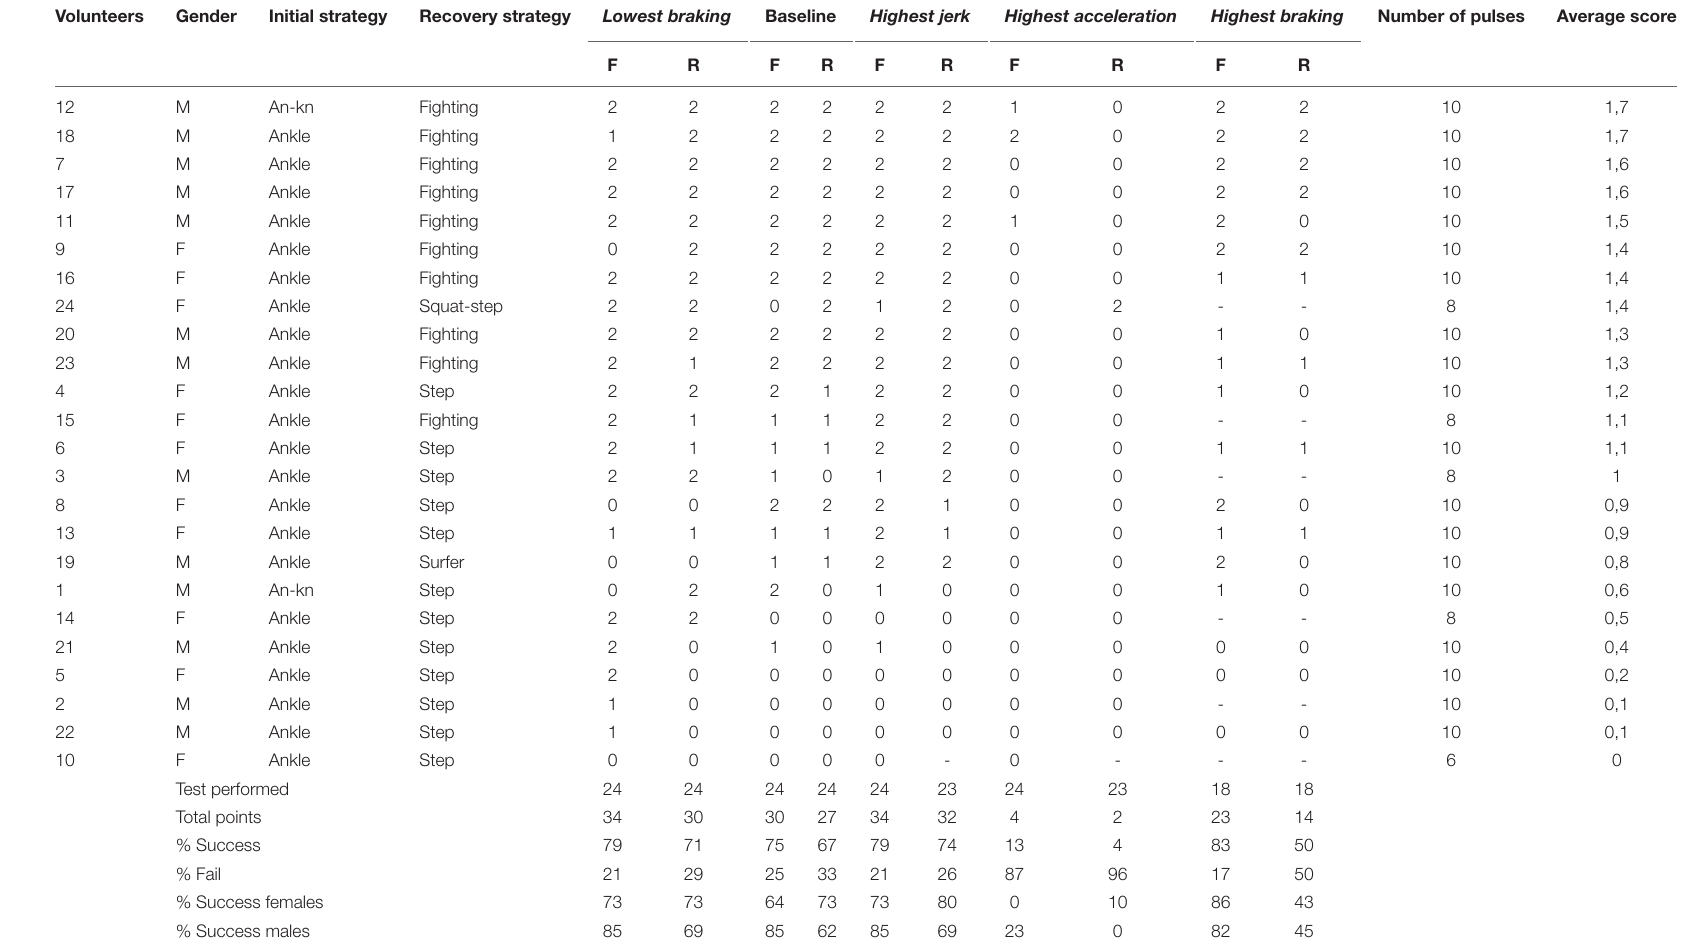
TABLE 5 | Tabulated grading of balance recovery during each perturbation and ranking of the volunteer outcome based on strategy effectiveness (M, male; F, female).